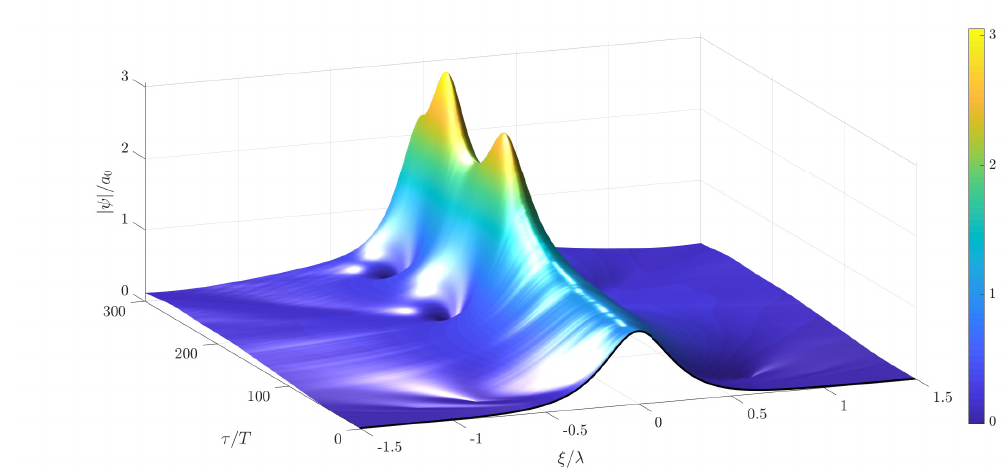
Figure 21. Different realization of the temporal evolution of a soliton solution of the stochastic MNLS with non-white noise excitation in time using the same parameters as in Figure 19. This solution shows the appearance of higher amplitude